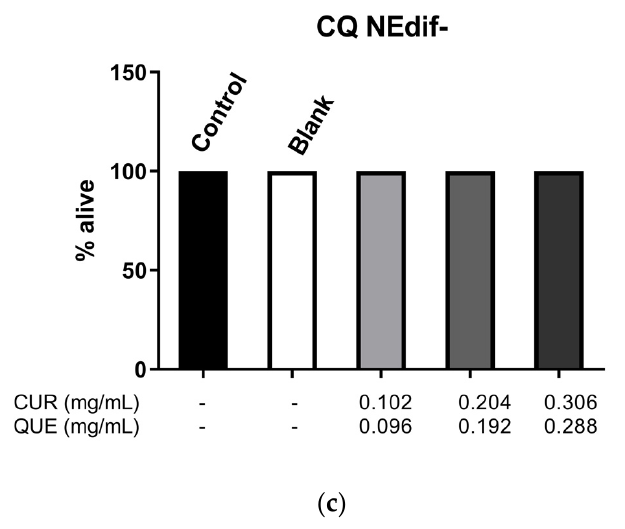
Figure 6. Survival rate of N2 C. elegans strain after 2 h exposition to different concentrations of CQ NE- ( a ), CQ NE+ ( b ), and CQ NEdif- ( c ). Data from three independent experiments.